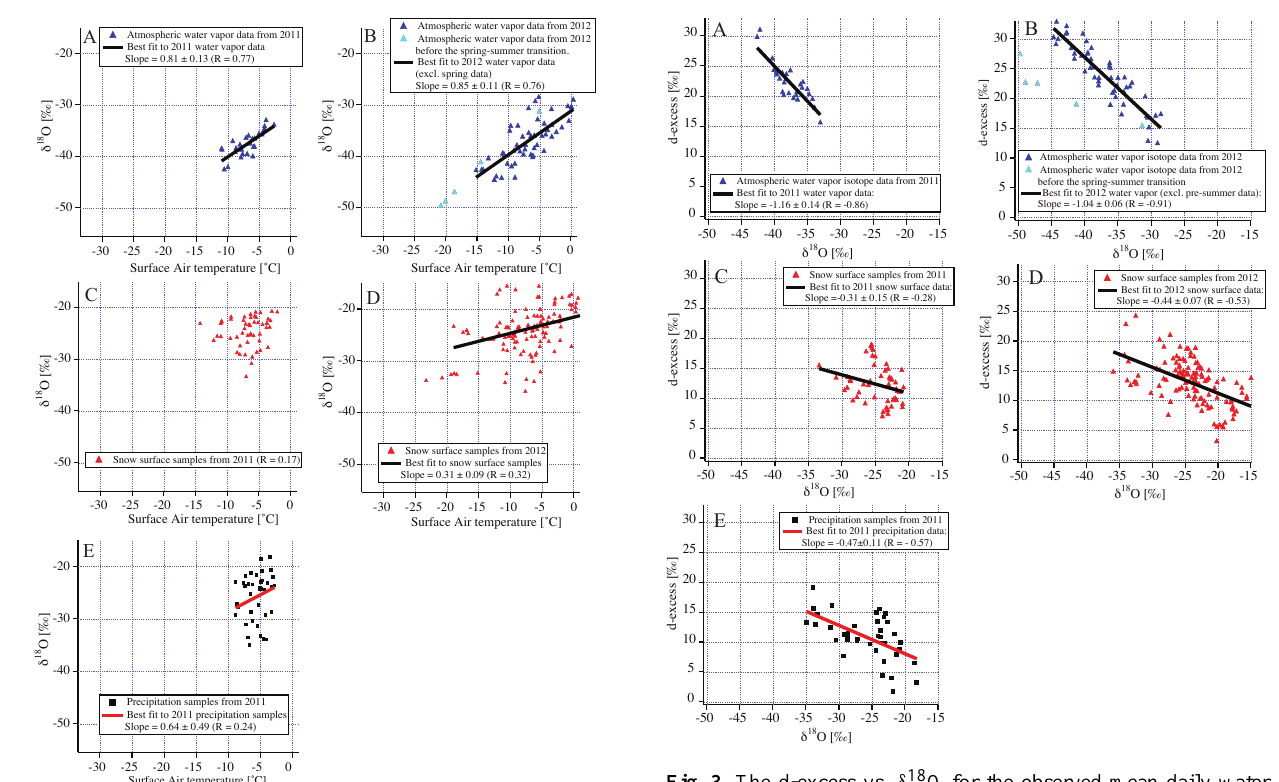
Fig. 2. The δ 18 O vs. surface air temperature for the observed mean daily water vapor isotopes ( A : 2011; B : 2012), surface snow sam-